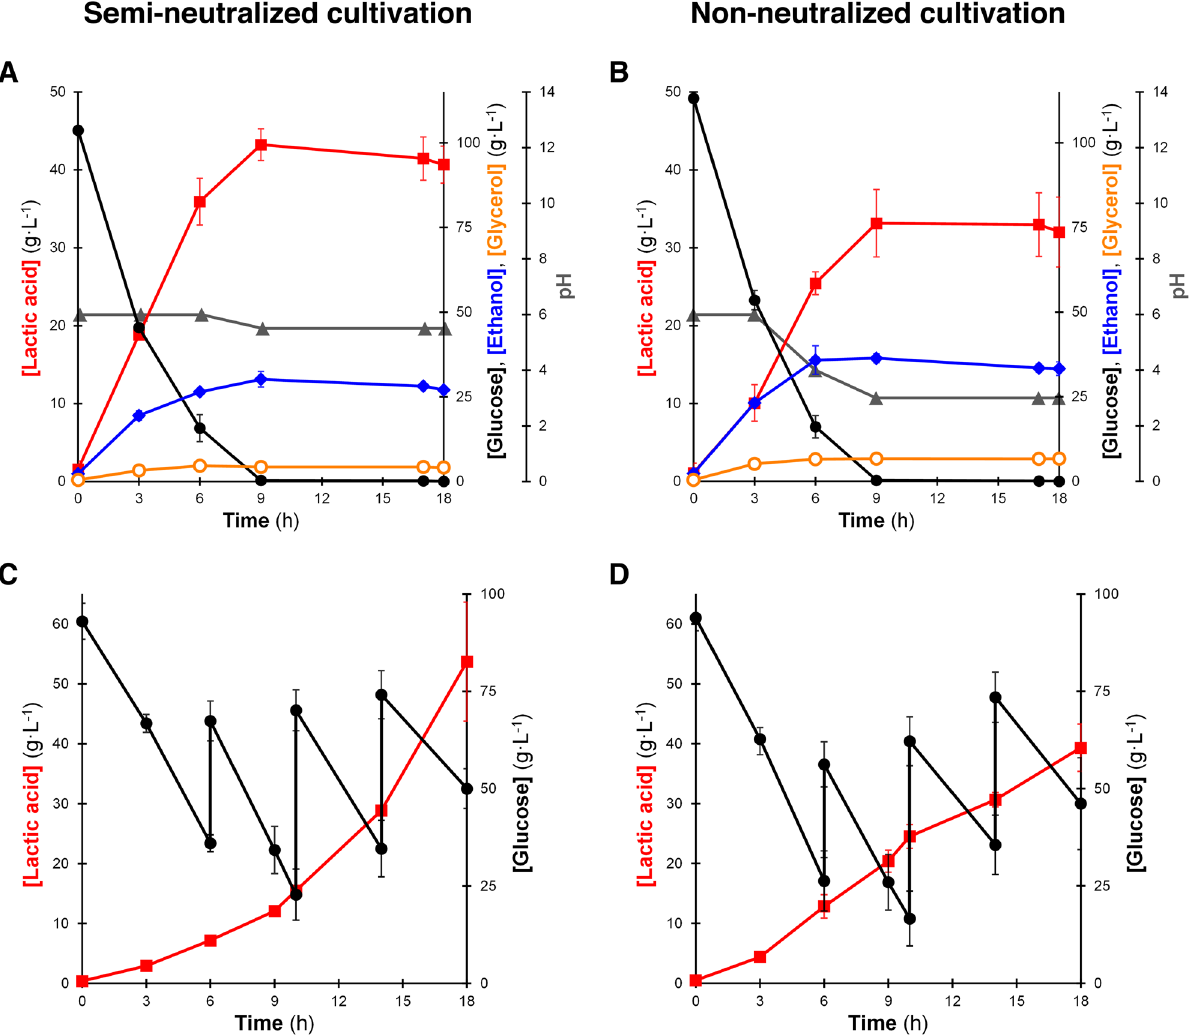
Figure 5. Fermentation products of Saccharomyces cerevisiae BTCC3LA2 strain using YPD medium under semi-neutralized ( A , C ) and non-neutralized ( B , D ) conditions in a batch ( A , B ) and fed batch ( C , D ) cultivation with the initial OD 600nm = 50. Line markers represent lactic acid (red boxes), glucose (black circles), ethanol (blue diamonds), glycerol (orange circles) and pH (grey triangles). Values represent the average measurement of four biological replicates. Error bars represent the standard deviation of